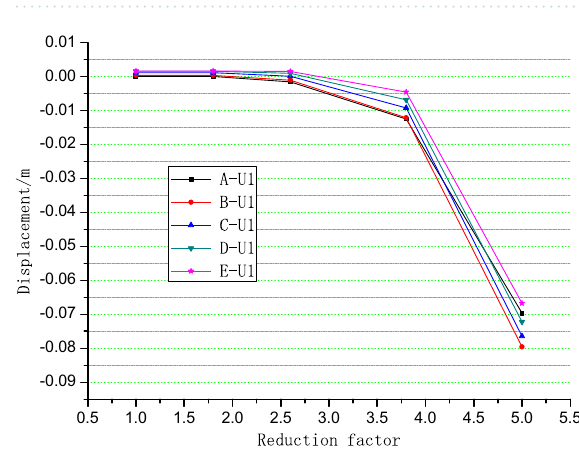
Figure 10. Monitoring points in the numerical simulation of the Lijiazhai slope.